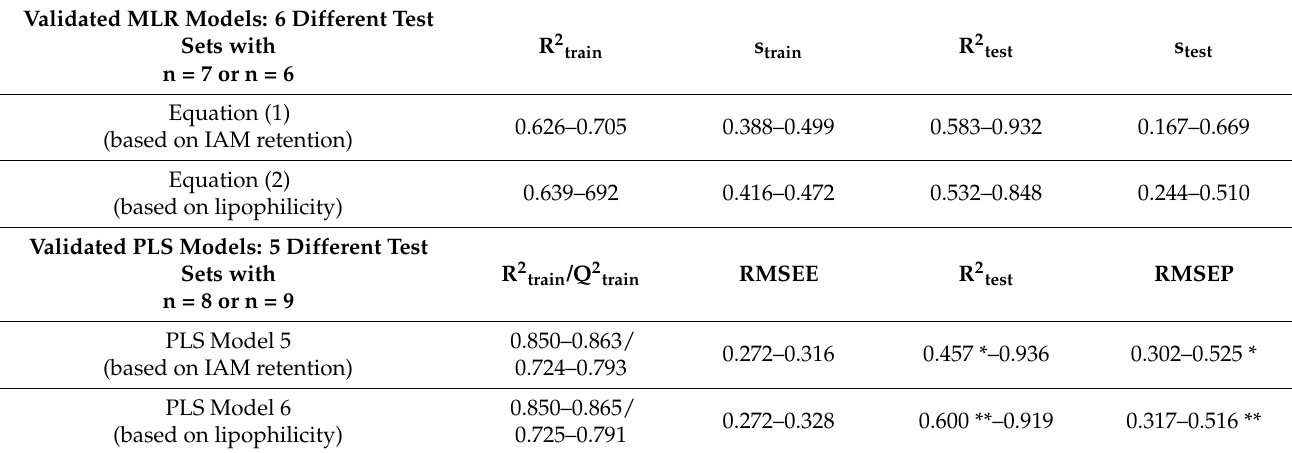
Table 2. Ranges of statistical values for training and external test sets for logBB validated